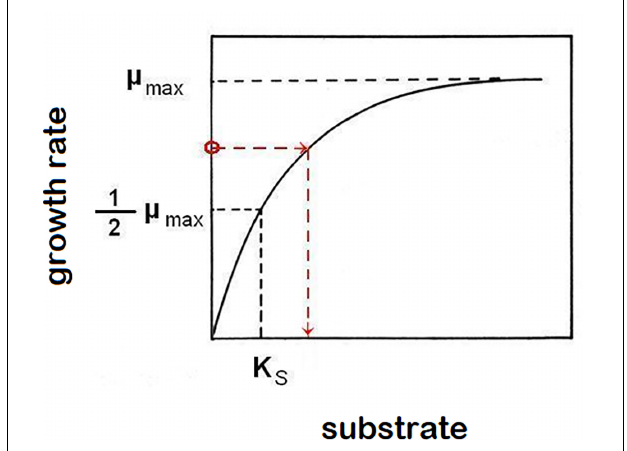
FIGURE 1 | Monod’s function of saturation curve. The function asymptotically approaches highest growth rate value µ max . Saturation constant K s is described as the limiting-nutrient (substrate) concentration that supports a half-maximum growth rate. In the chemostat, growth rate ( µ ) equals dilution rate ( D ). This causes a reverse effect, when the growth rate of cells in suspension controls the concentration of limiting nutrient (example is shown by red broken line, but any point of the function represents that